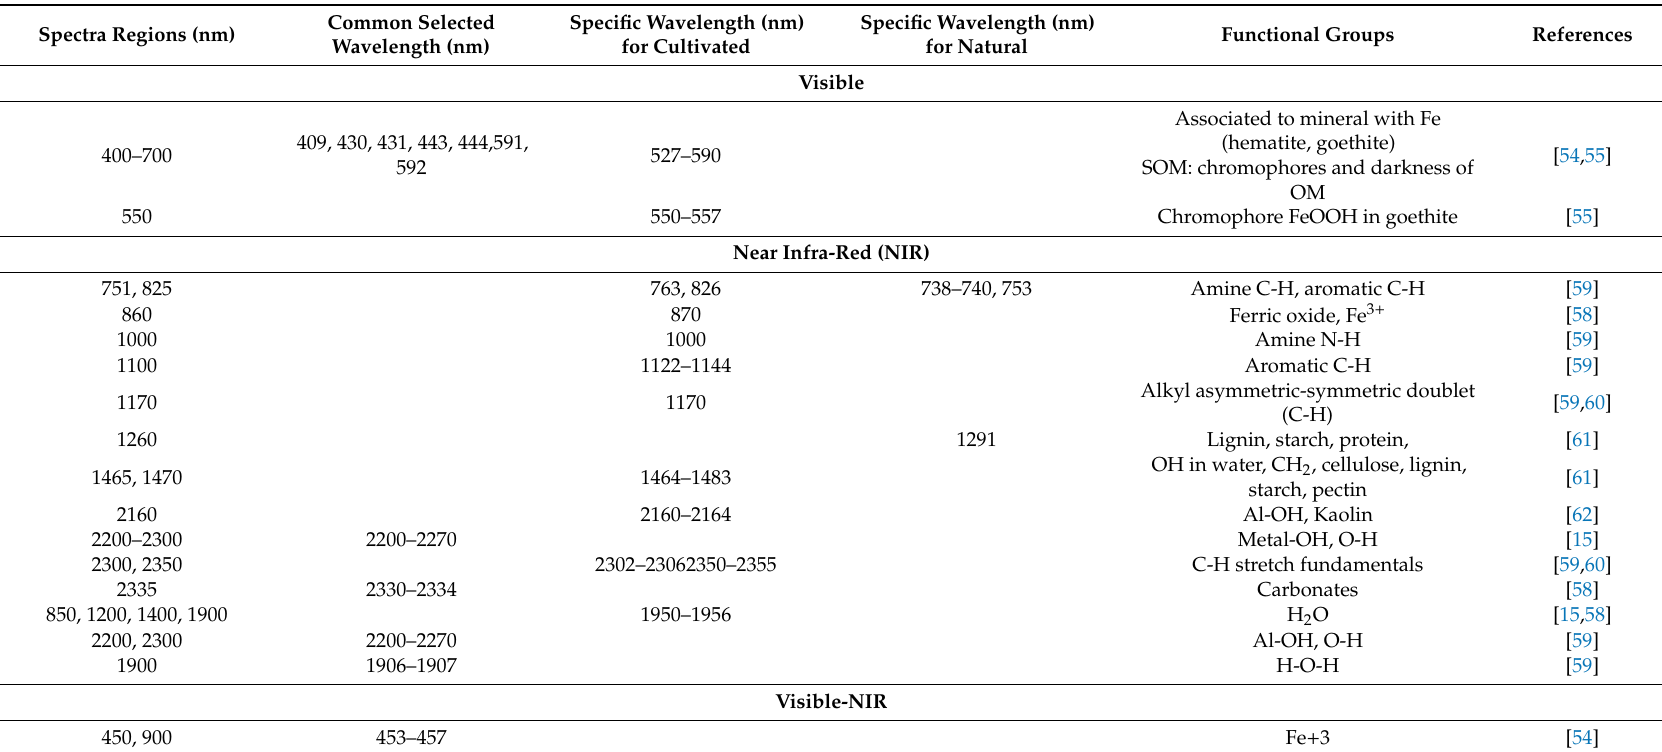
Table 7. Selected visible and near infra-red (NIR) wavelengths related to soil components and functional groups as reported in the literature, and common and specific selected wavelengths observed in our